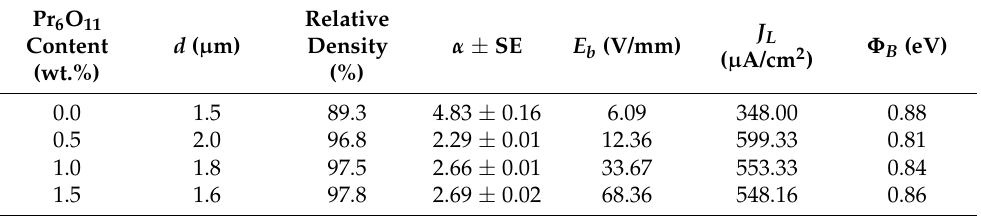
Table 5. Average grain size ( d ), Relative density, nonlinear coefficient ( α ), breakdown voltage ( E b ), leakage current density ( J L ), and Schottky barrier height ( Φ B ) of Pr 6 O 11 at different content.